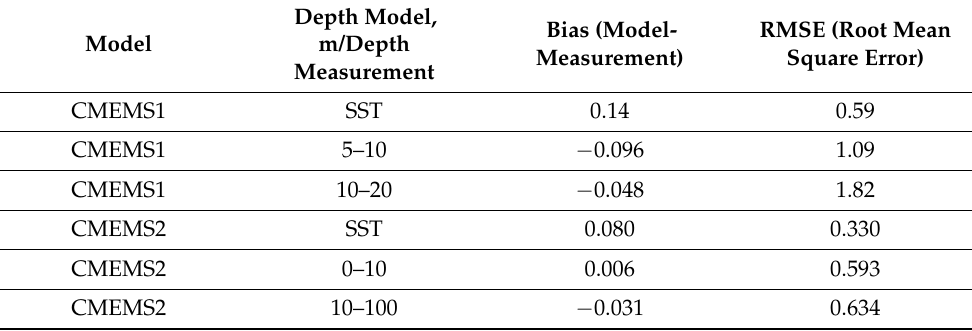
Table 5. Accuracy estimates of CMEMS1 and CMEMS2 models from QUID reports [57,71].